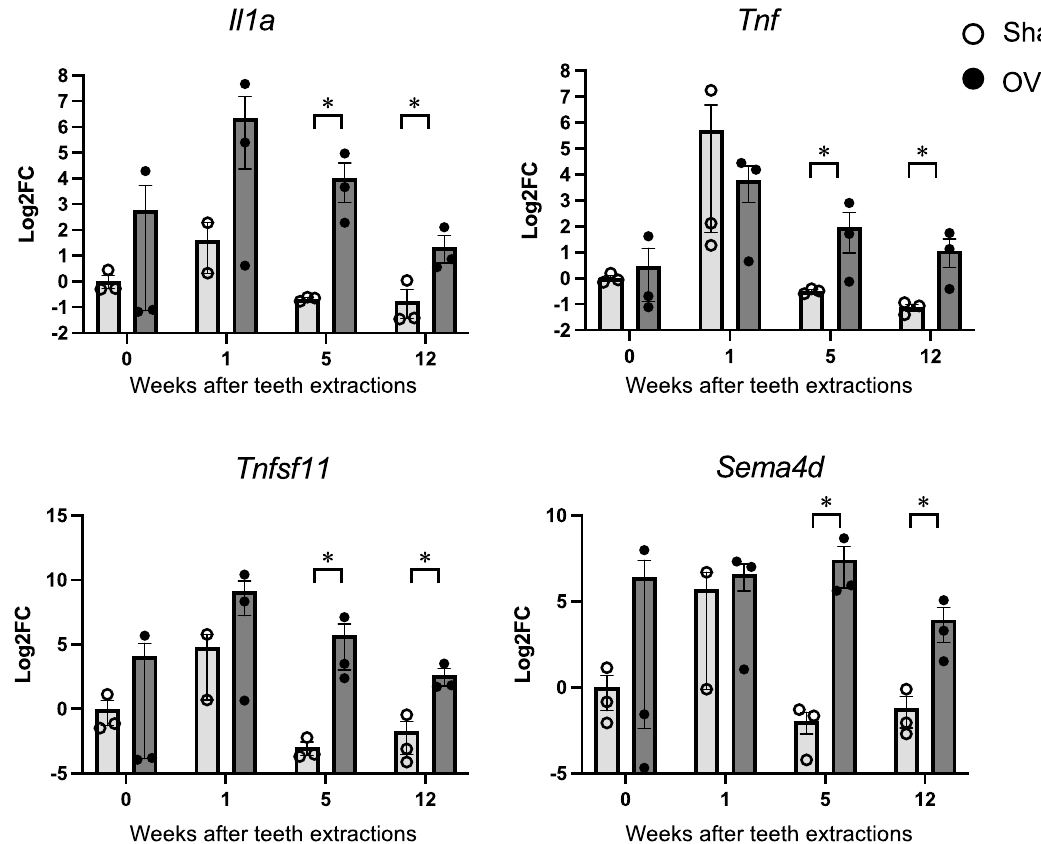
Figure 4. Ovariectomy sustains prolonged high expression of several mRNAs encoding bone metabolism and proinflammatory cytokines after teeth extractions. The expressions of mRNA encoding bone metabolism in the maximally alveolar bone were examined via quantitative PCR in both OVX mice (closed circle) and sham mice (open circle). The graphs show relative expressions of indicated genes normalized to the expression level of day 0 of the sham mice. Data are expressed as mean ± S.E. Three mice were used in each group. * P < 0.05; calculated using Student’s t increased BV. We further demonstrated that administration of a neutralization antibody for Sema4d efficiently prevented femur bone loss in ovariectomized mice 16 . In our experimental model, administration of Sema4d neutralization antibodies into OVX mice significantly suppressed the loss of alveolar BV after teeth extractions. This result suggested that Sema4d is a factor involved in the promotion of bone resorption after tooth extrac- tion and that inhibition of Sema4d may be a useful treatment for RRR. Consistent with our study, a recent study reported the therapeutic effects of small interfering RNA for silencing Sema4d mRNA, which increased the BV over the total volume of the mandibular bone and prevented alveolar bone height loss in an osteoporotic model 30 . RANKL is a tumor necrosis factor (TNF) cytokine family and functions as a key factor for osteoclast differen- tiation and activation. Human anti-RANKL neutralizing antibodies are utilized for the treatment of osteoporosis and cancer-induced bone diseases. Administration of RANKL antibodies into OVX mice also suppressed long- lasting alveolar bone resorption after teeth extractions in our experimental model. Noteworthy, this antibody was sufficiently effective with a single dose immediately after tooth extraction. It has been pointed out that RANKL-neutralizing antibodies have the risk of causing antiresorptive agent- related osteonecrosis of the jaw (ARONJ), which is local osteonecrosis of the maxilla and mandible with no symptoms in other bones 31,32 . In our experimental model, however, no significant signs of maxilla bone necrosis were found. This result indicated that some additional factors, such as chronic inflammation caused by peri- odontal disease or excessive stimulation from dentures, may be required for the onset of ARONJ in addition to